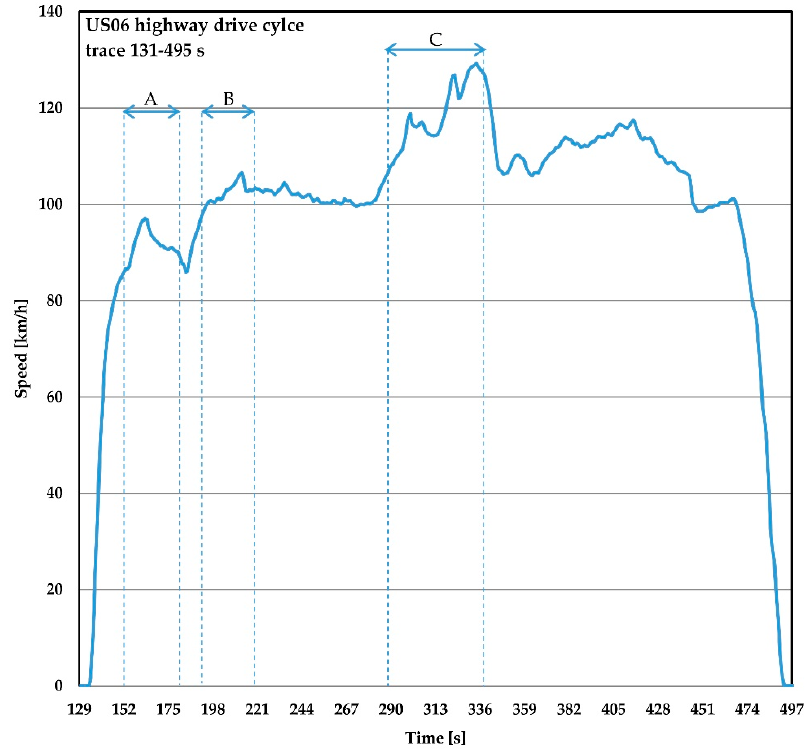
Figure 11. Velocity profile for highway mode corresponding to US06 driving